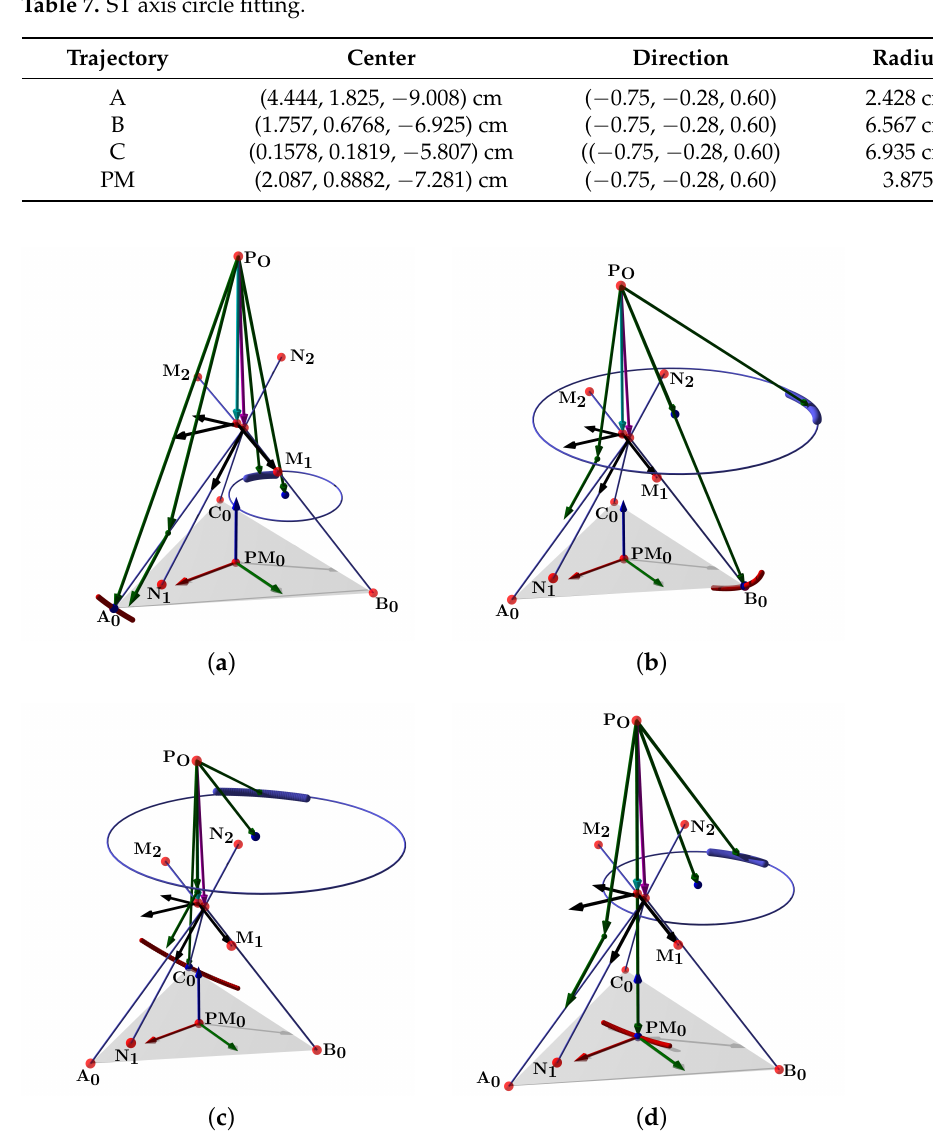
Figure 37. ST axis circle fitting: ( a ) trajectory A, ( b ) trajectory B, ( c ) trajectory C, ( d ) trajectory